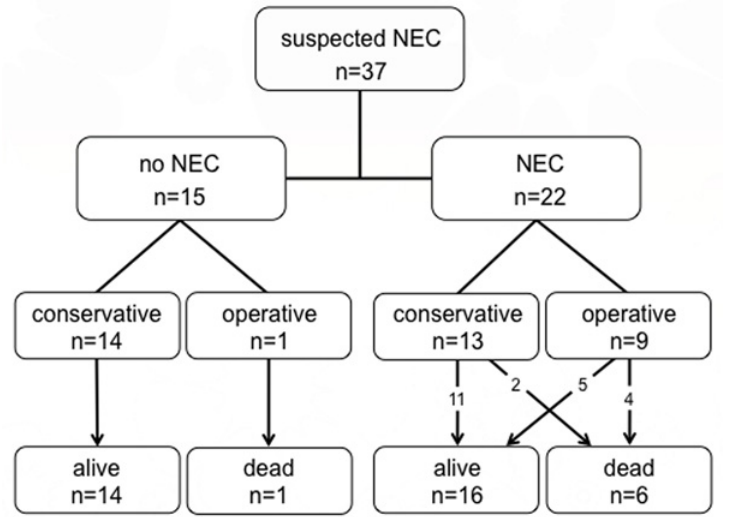
Fig 5. Flow chart of patient